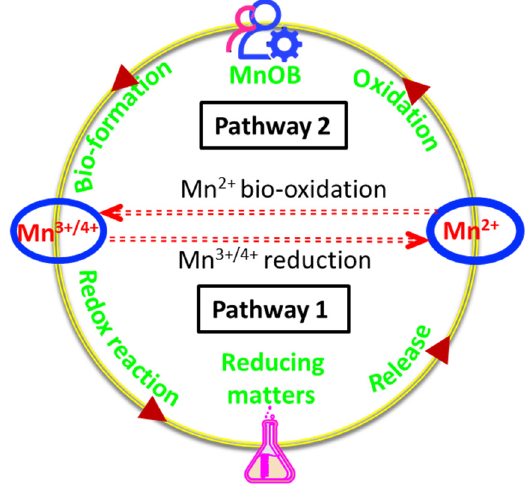
Figure 1. The diagram of the Mn cycle mediated by MnOB and reducing matters.